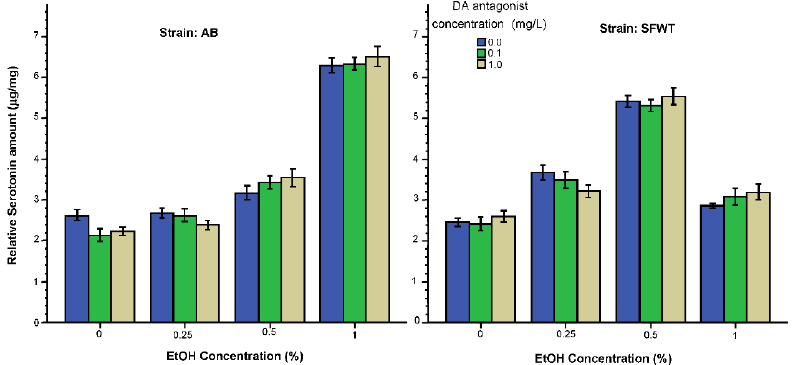
Figure 9. Serotonin levels relative to total brain protein weight are influenced by the concentration of acute alcohol (X-axis) but not by the concentration of acute D1-R antagonist (legend). Additionally, note the strain dependent alcohol dose responses (alcohol x strain interaction). Mean ± S.E.M. are